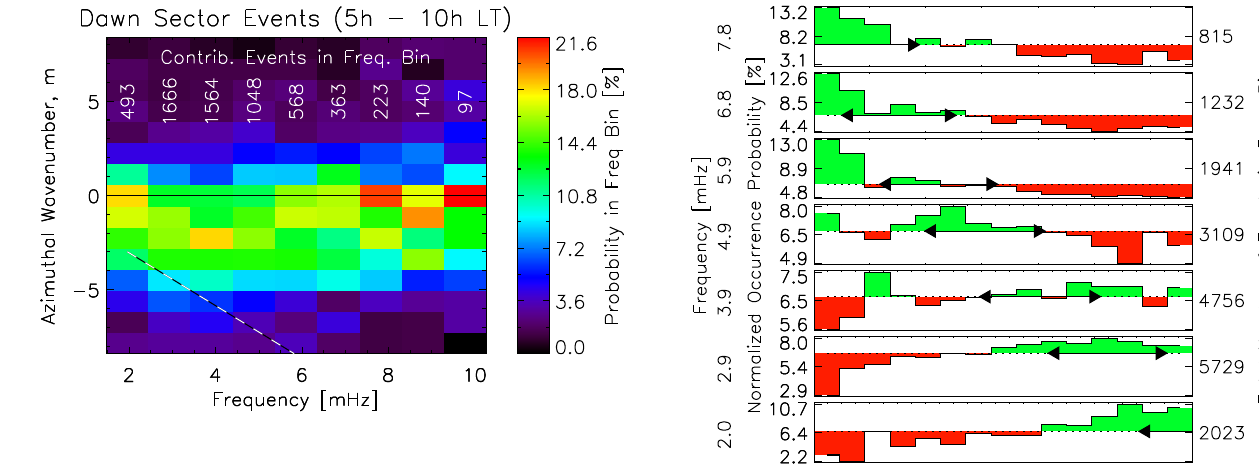
Fig. 11. Distribution of occurrence probability for dawn sector events (between 05:00 and 10:00LT) within the frequency bins against the azimuthal wavenumber m . Binning of m axis: 1 . 1. The number of events contributing to each frequency bin is shown in the upper part. The dashed line depicts the relation found by Olson and Rostoker (1978).